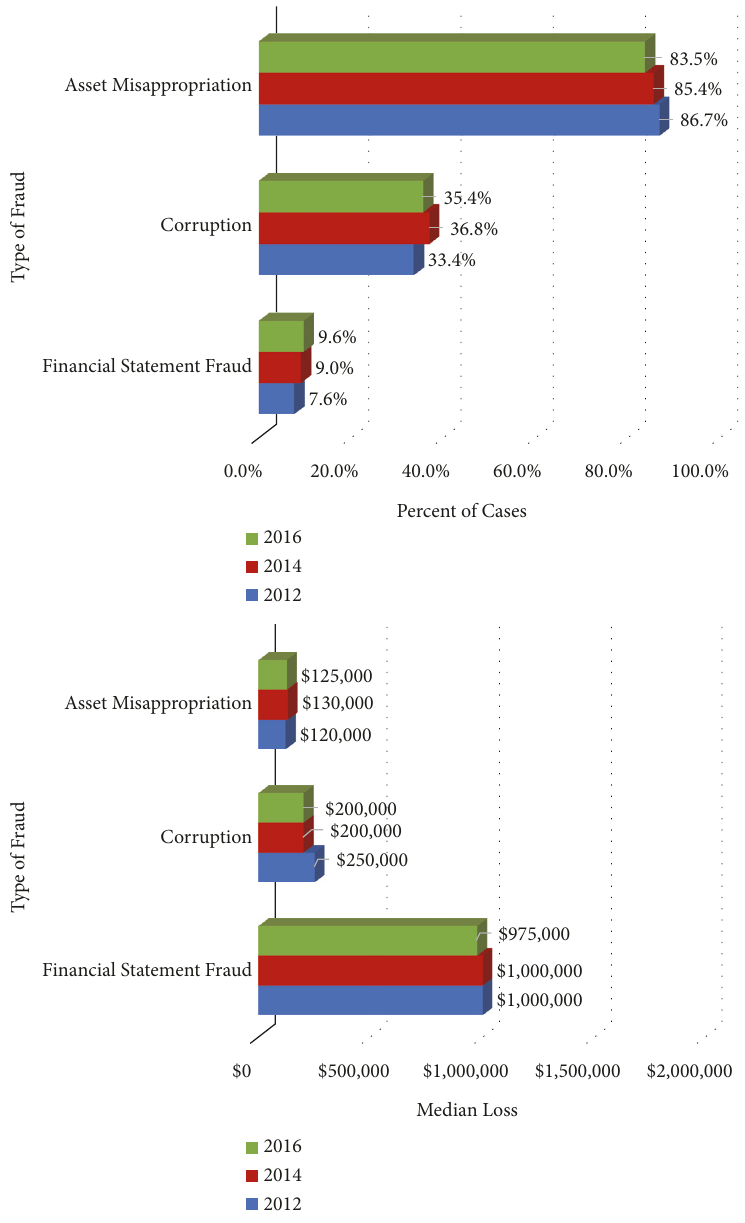
Figure 1: Occupational fraud and its frequency and median